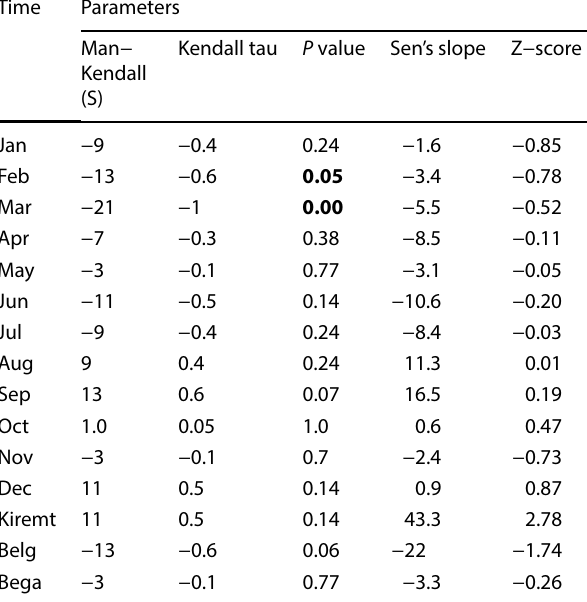
Table 4 MK test result of annual RF Stations